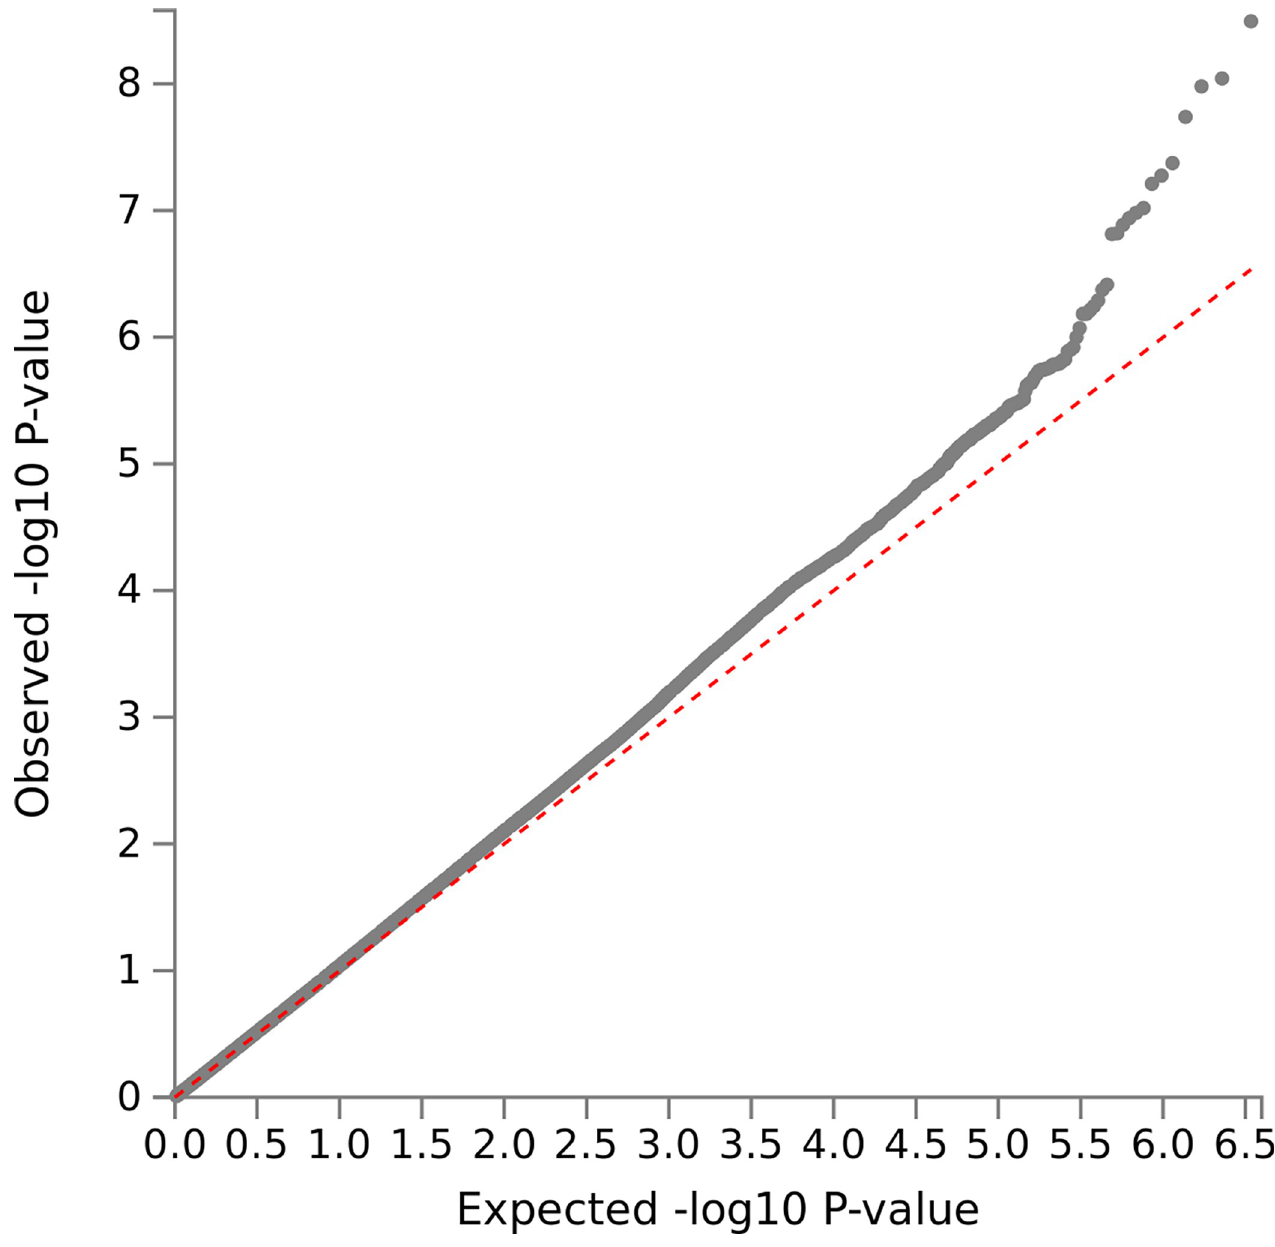
Fig 1. QQ-plot. Quantile-quantile plot of observed -log 10 p values vs expected -log 10 p values assuming chance findings in single SNP analysis. Diagonal line indicates a p value distribution compatible with chance finding. Upward deviations indicate p values more significant than expected.